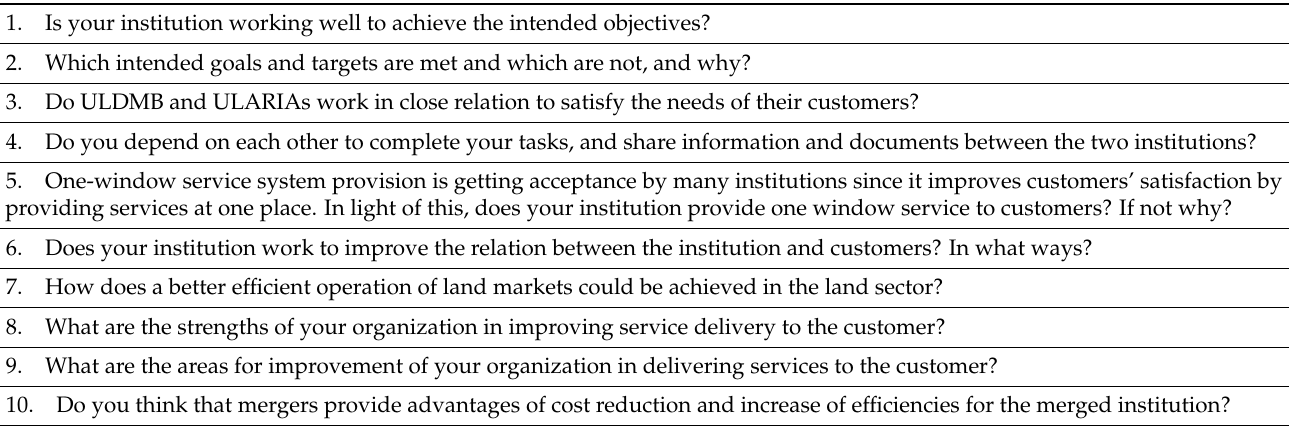
Table A1. Semi-structured interview and focused group discussion questions provided to ULDMB and ULARIA